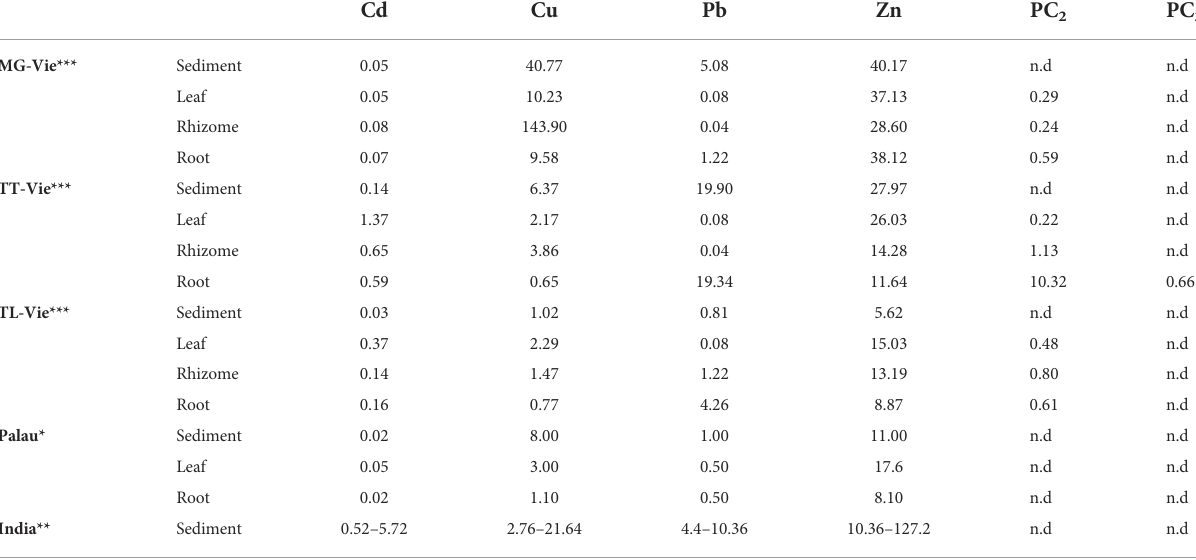
TABLE 4 Comparison of concentration of selected heavy metals in the rhizosphere sediment, distinct organs, and phytochelatins (PCs) in Enhalus acoroides from different locations along the coast of Khanh Hoa province and other